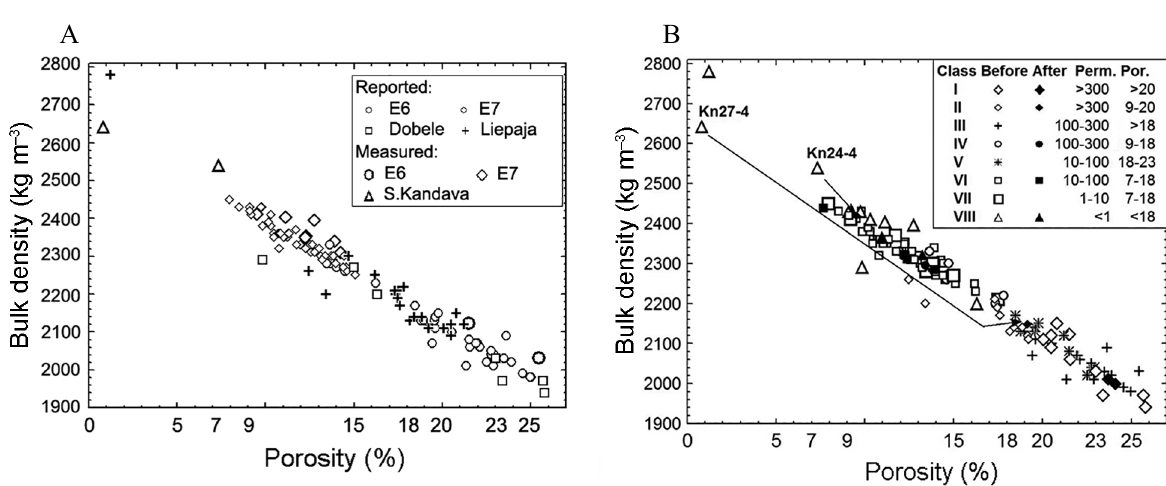
Fig. 3. Bulk density measured on dry samples versus porosity of the sandstones of the Deimena Formation from two offshore and three onshore structures: ( A ) for 115 samples reported and measured from seven boreholes before alteration; ( B ) for 115 samples reported and measured before alteration (empty symbols) and 12 samples measured after alteration (black symbols) in terms of reservoir quality classes I–VIII (Tables 1, 2). Perm., gas permeability; Por.,